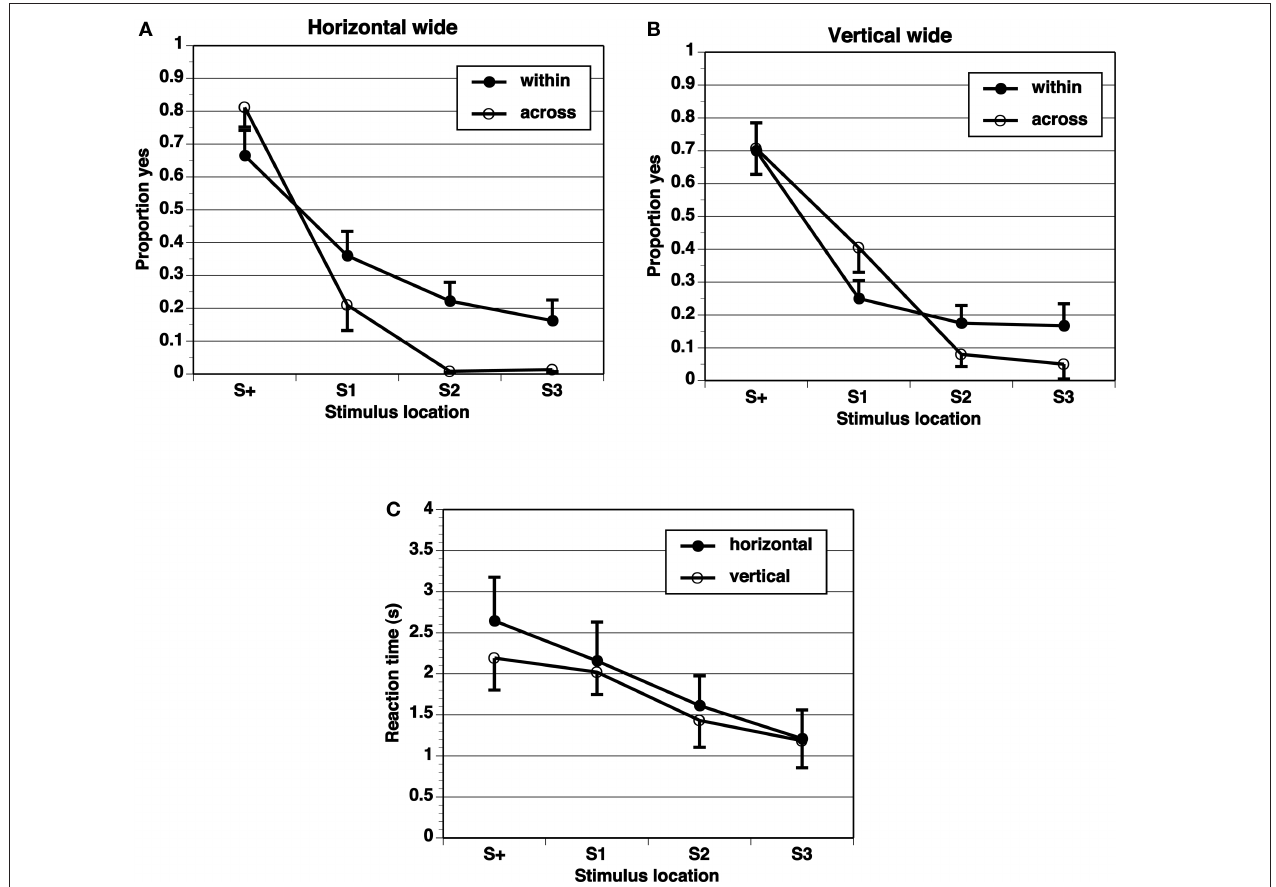
Figure 3 | Proportion of “yes” responses (A, B, M ± SeM) and reaction times (C, M ± SeM) in the Wide-4 experiment, with wide spacing between stimulus locations and four test